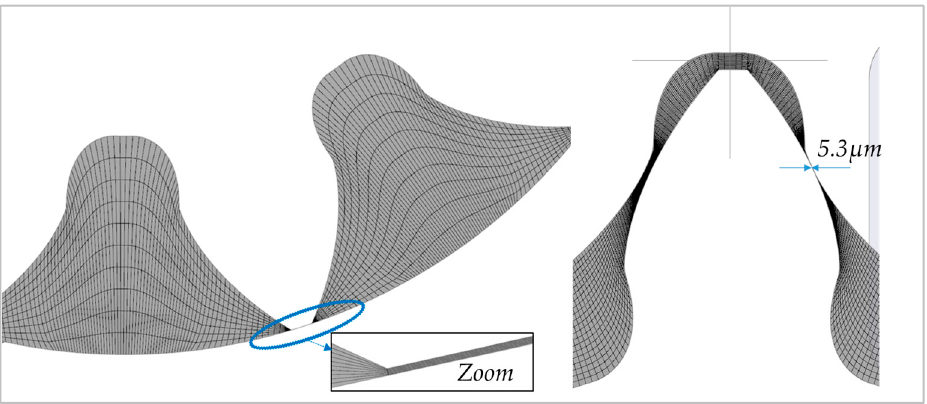
Figure 5. Mesh of the rotating fluid volume and size of the minimum gaps.